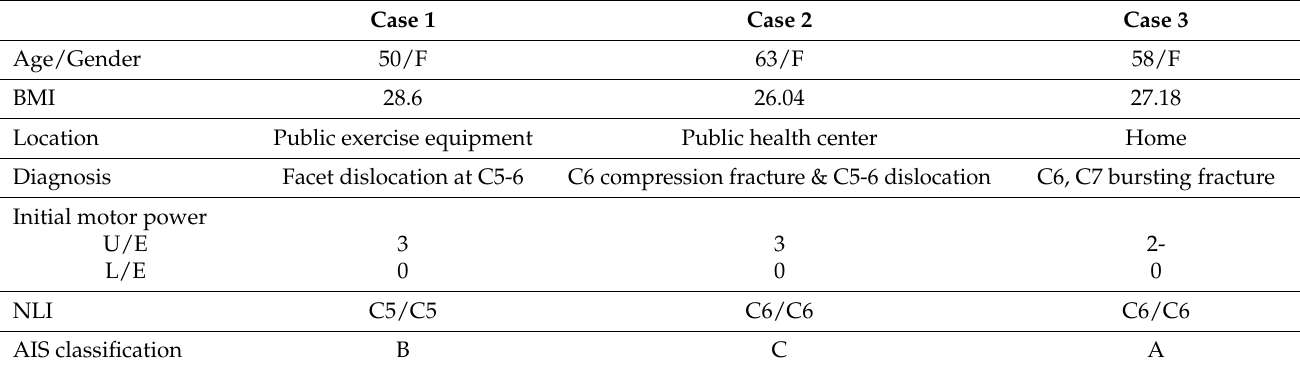
Table 1. Summary of the clinical characteristics in described